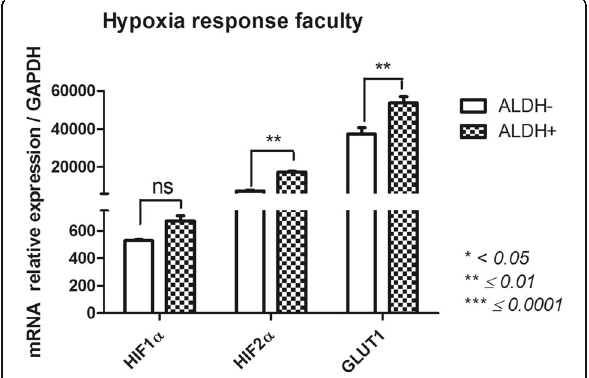
Fig. 5 Phenotype-related gene expression profile of FSK-MSC subsets according to ALDH activity. After flow cytometry sorting of ALDH+ and ALDH- FSK-MSC subsets, we investigated by qPCR the expression profiles of phenotype-associated genes CD54, CD58 and CD106 . Data are presented as mean ± SEM of mRNA gene expression relative to GAPDH expression